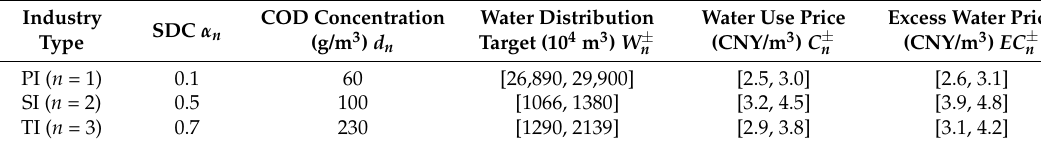
Table 2. Water distribution target, water price data and others associated.